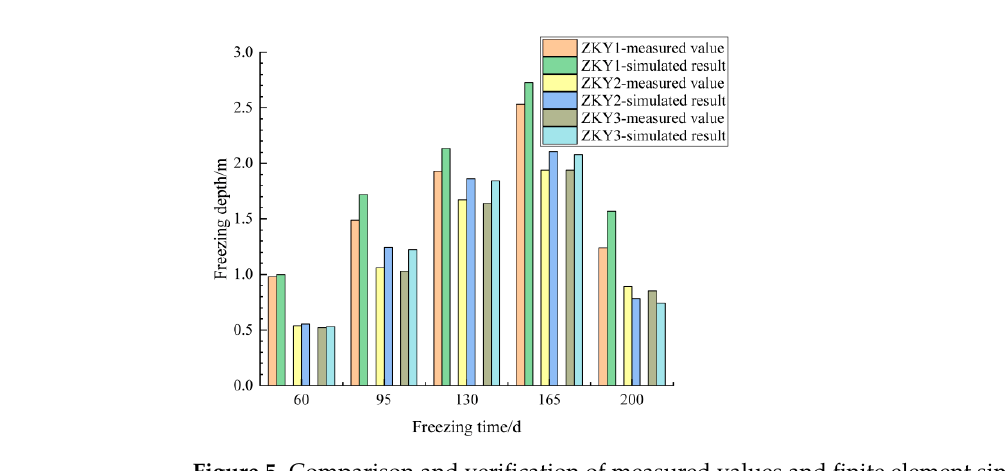
Figure 5. Comparison and verification of measured values and finite element simulated values of freezing depth (unit: m).